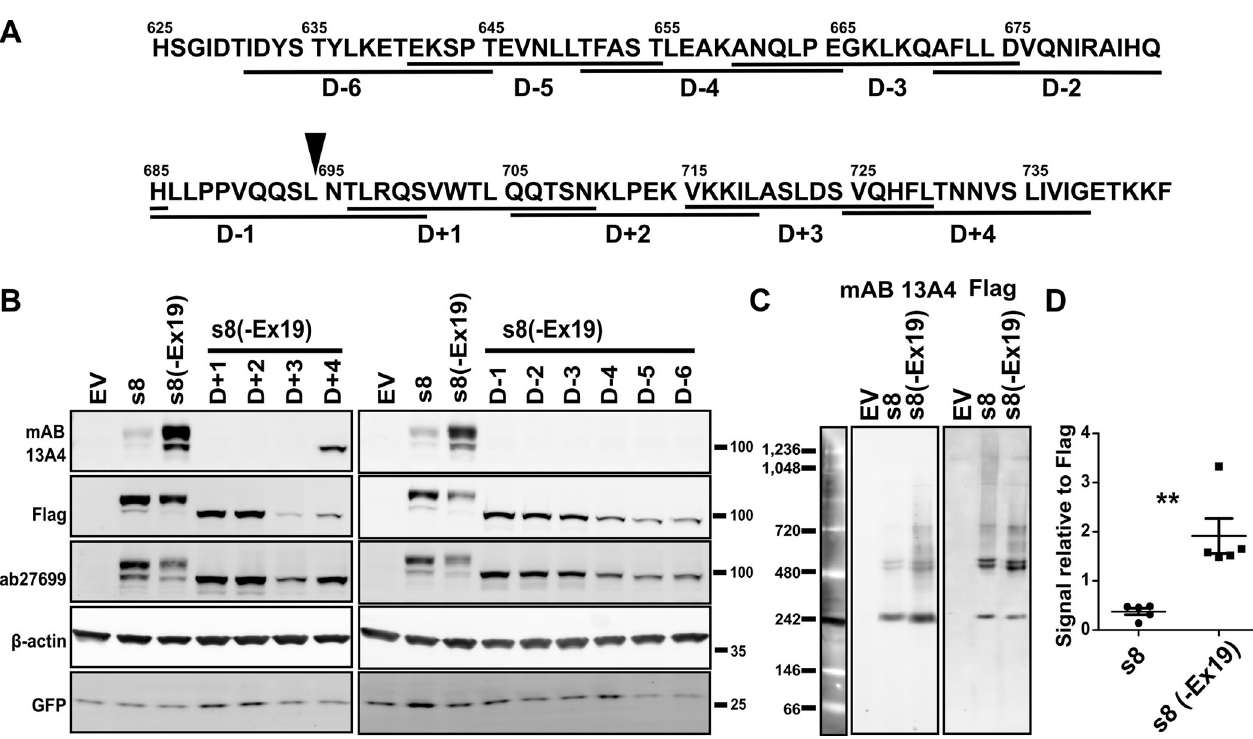
Fig 4. Mapping of the mAB 13A4 epitope. A) Sequence of the third extracellular domain. Underlining shows the positions of the deletions used for epitope mapping. The deletion variants were generated starting from the s8 clone lacking exon 19, s8(-Ex19). Solid triangle above the sequence shows the position where exon 19 is inserted in the photoreceptor specific isoform. B) Western blot analysis of PROM1 deletion mutants expressed in N2a cells using mAB 13A4 and Flag-tag antibodies. All mutants with exception of D+4 resulted in loss of the mAB 13A4 epitope. Transfection with empty pcDNA3.1 vector (EV) was used as a negative control. All transfections were spiked with a vector expressing GFP to control for transfection efficiency. C) Native gel Western blot analysis using mAB 13A4 and Flag-tag antibodies of N2a cell lysate transfected with either an empty vector (EV), s8, or s8(-Ex19). D) Quantification of mAB 13A4 signals relative to the signal from the Flag-tag antibody in native gel electrophoresis western blot. Dots represent individual data points. Line and error bars the mean and the standard error of the mean (n = 5). Unpaired Student’s t-test was used to assess the statistical significance and the p-values were less than 0.01 (indicated by “ ��